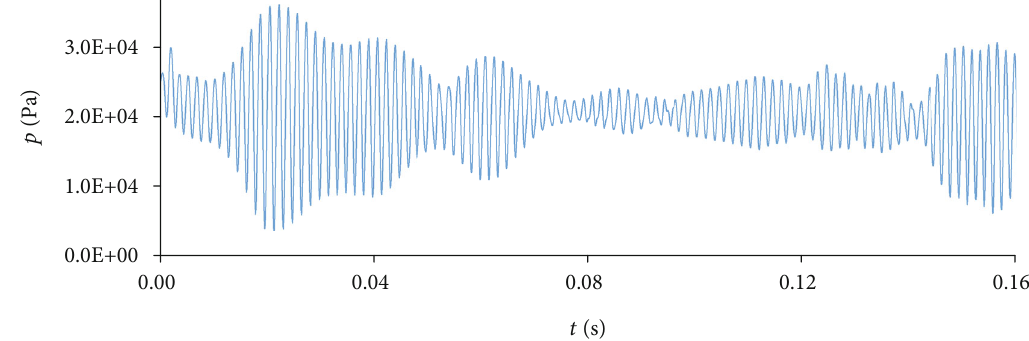
Figure 16: Average pressure-time curve at fracture